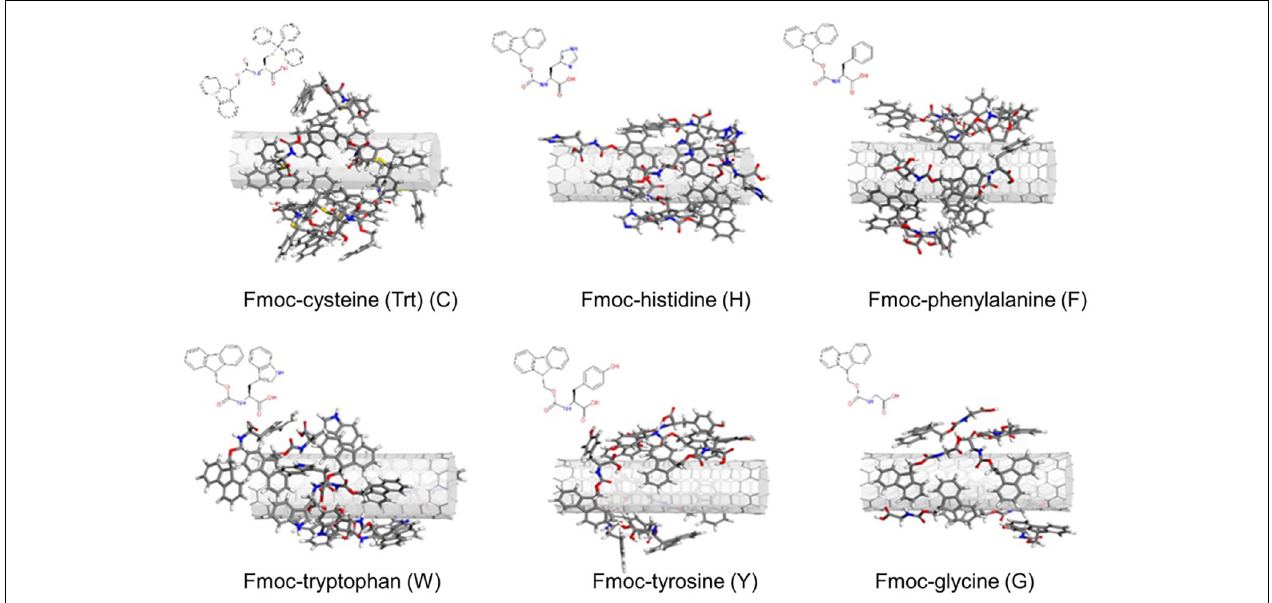
FIGURE 1 | Configurations of the Fmoc – amino acids on the SWNT surface obtained with simulated annealing simulations.